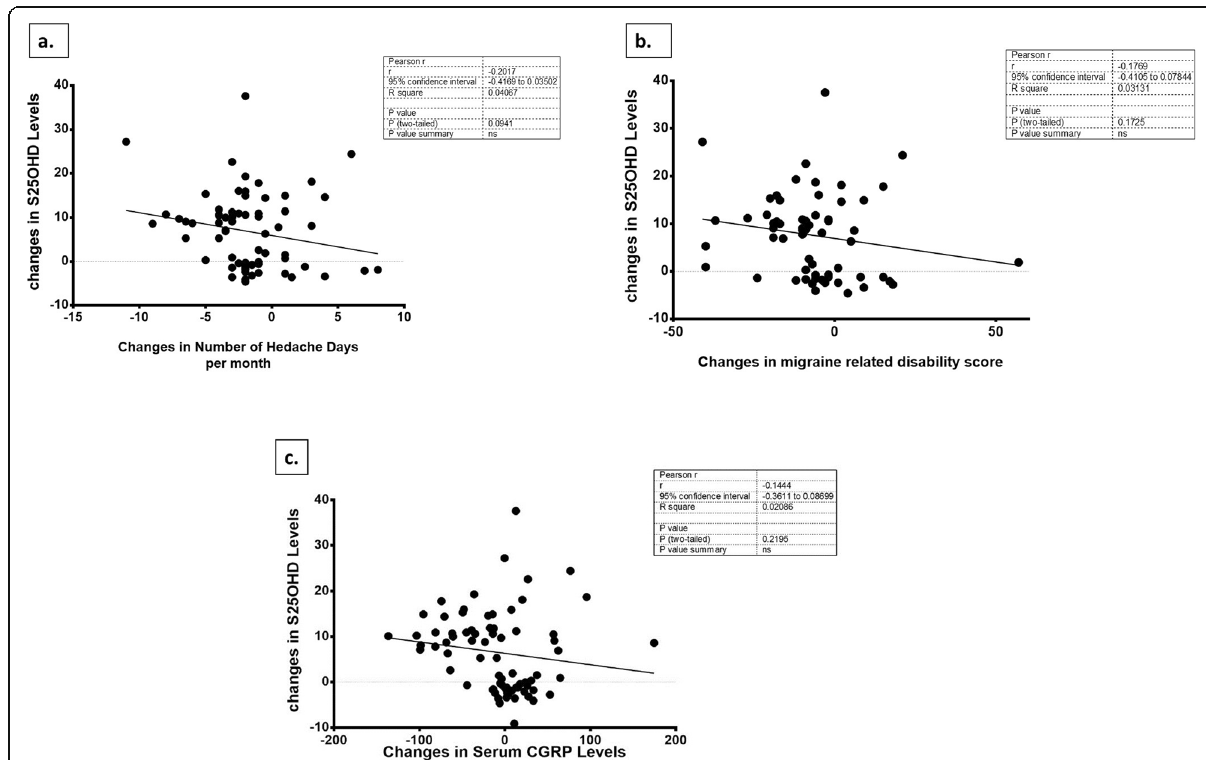
Fig. 4 a The Correlation between changes in serum 25OHD and number of headache days per month throughout 12-week trial. b The Correlation between changes in serum 25OHD and migraine related disability score (MIDAS, migraine Disability Assessment score) throughout 12-week trial. c The Correlation between changes in serum 25OHD and CGRP (calcitonin gene-related peptide) levels throughout 12-week